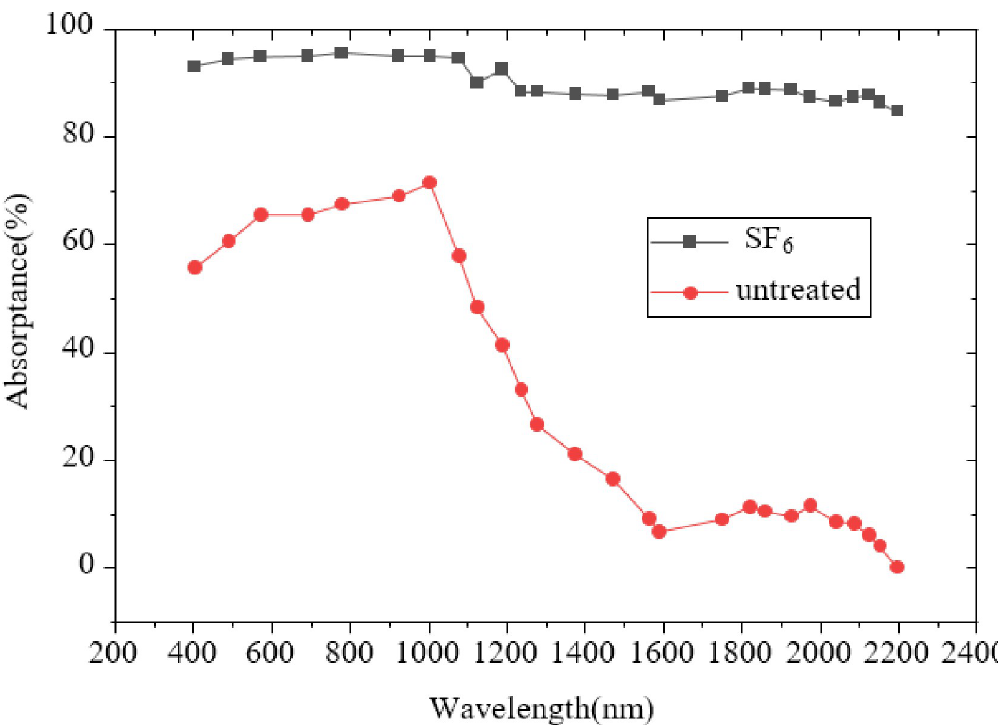
Fig 6. Comparison of absorption spectra of black silicon sample and monocrystalline silicon etched with SF 6 as background gas.